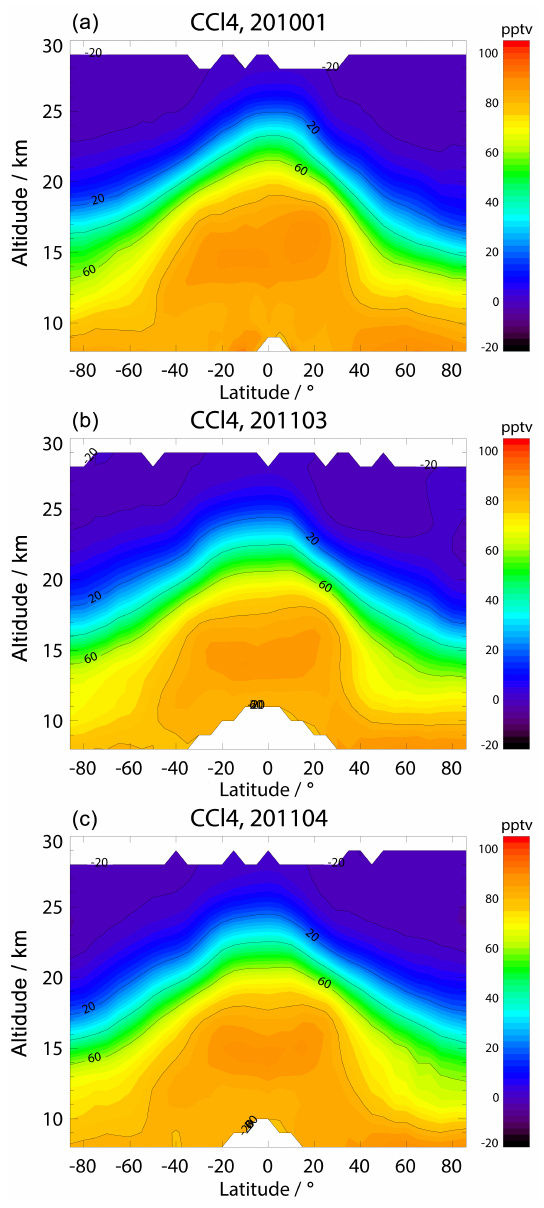
Figure 8. Altitude–latitude cross sections of MIPAS CCl 4 for the RR period. (a–c) January 2010, March 2011 and April 2011.